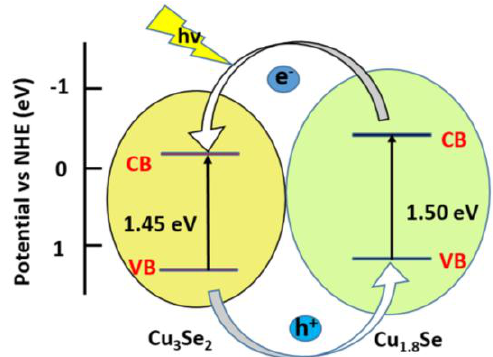
Figure 7. Diagram of energy band levels of Cu 1.8 Se/Cu 3 Se 2 composites vs. NHE (normal hydrogen electrode) and the possible charge separation process.